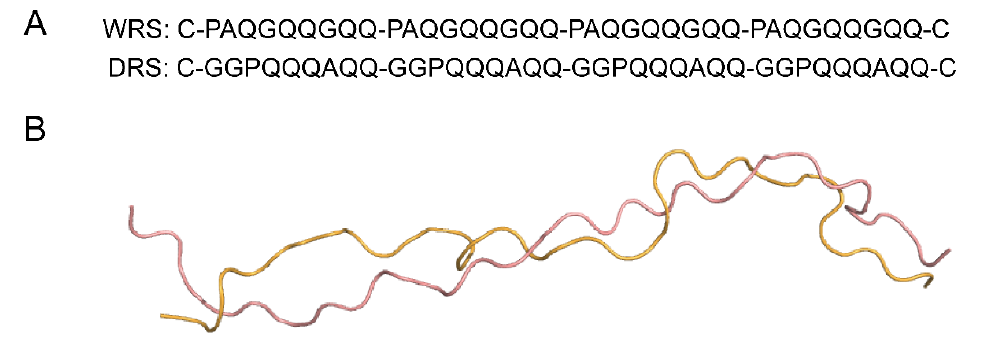
Figure 4. Primary and simulated tertiary structures of the repetitive sequences. ( A ) primary sequence of WRS (wild-type) and DRS (designed variant). ( B ) the simulated solution structures of free WRS (bright orange) and DRS (salmon).